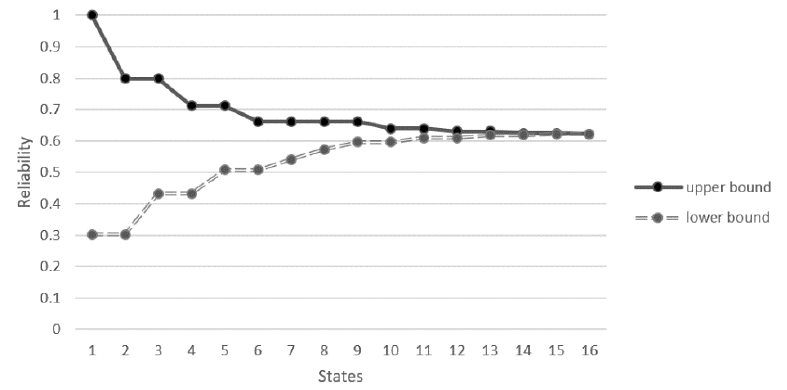
Figure 3. Reliability upper and lower bounds analysis based on road network capacity.